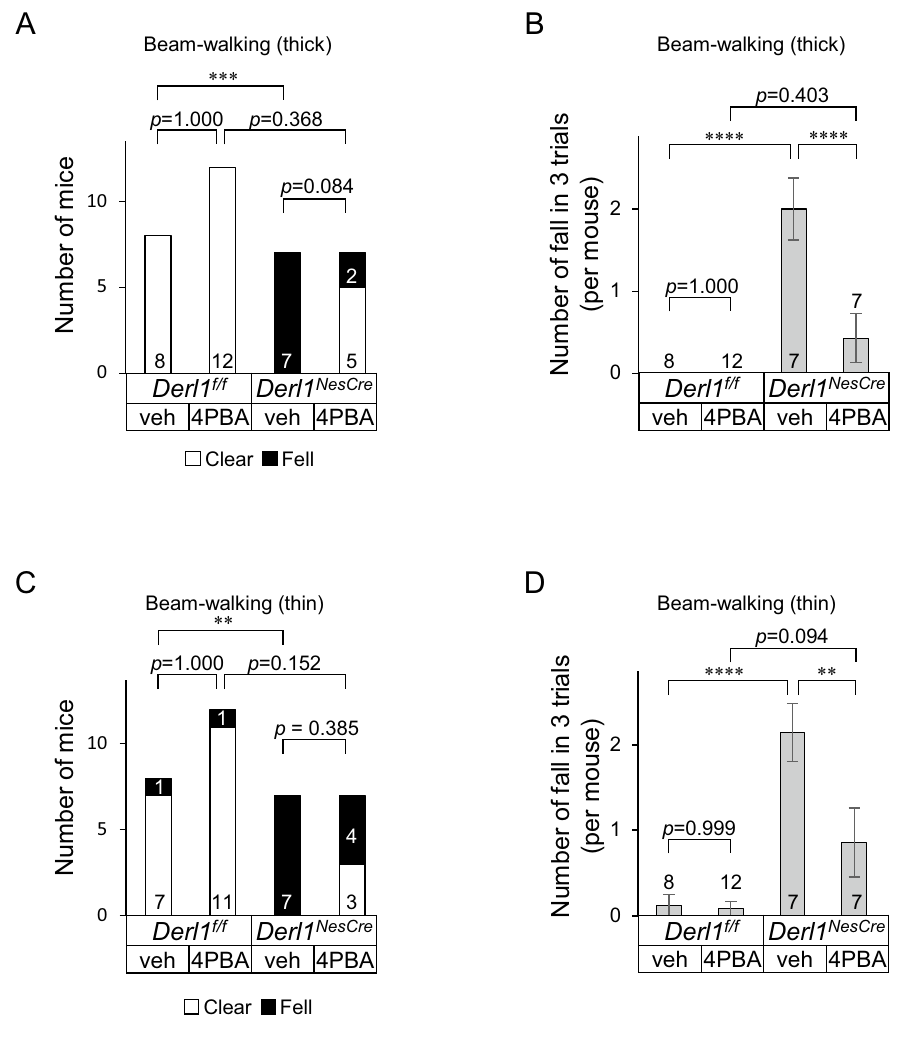
Figure 4. Chemical chaperone improves motor dysfunction. ( A – D ) Beam-walking test was performed after vehicle or 4-PBA was administered by ad libitum access to each solution from P14 to approximately 13 weeks of age. Mice walked three trials per day on a thick beam on the first day ( A , B ) and a thin beam on the second day ( C , D ). ( A , C ) Comparison of the number of mice that fell off one or more times in three trials (Fell) and the number that safely reached the platform in three of three trials (Clear). ( B , D ) Comparison of the number of falls in three trials per mouse. Data information: bar graphs are presented as mean ± SEM. * P < 0.05; ** P < 0.01; *** P < 0.001; **** P < 0.0001; Fisher’s exact test followed by Holm’s test ( A , C ); one-way ANOVA followed by Tukey’s test ( B , D